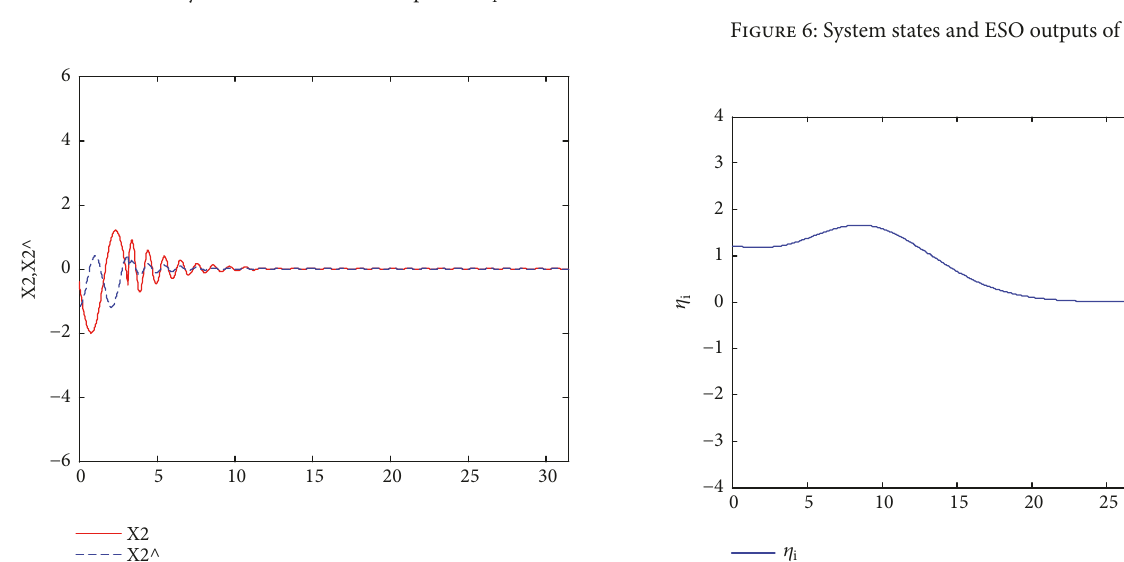
Figure 3: System states and ESO outputs of 𝑥 1 .